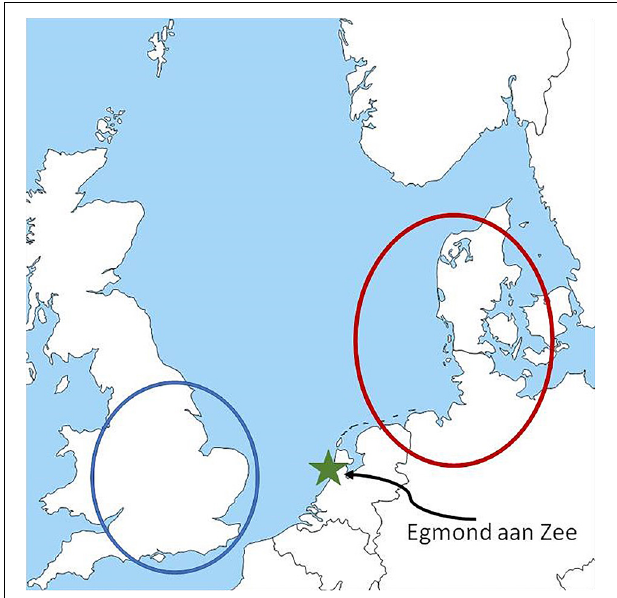
FIGURE 1 | The map of study area around the North Sea. The star indicates the position of Egmond aan Zee wind farm, where the radar is located. The blue circle indicates the most probable departure area of the migrants on nights of high migration intensity in spring. The red circle indicates the most probable departure area of the migrants on nights of high migration intensity in autumn outside of the Netherlands according to Bradari´c et al.